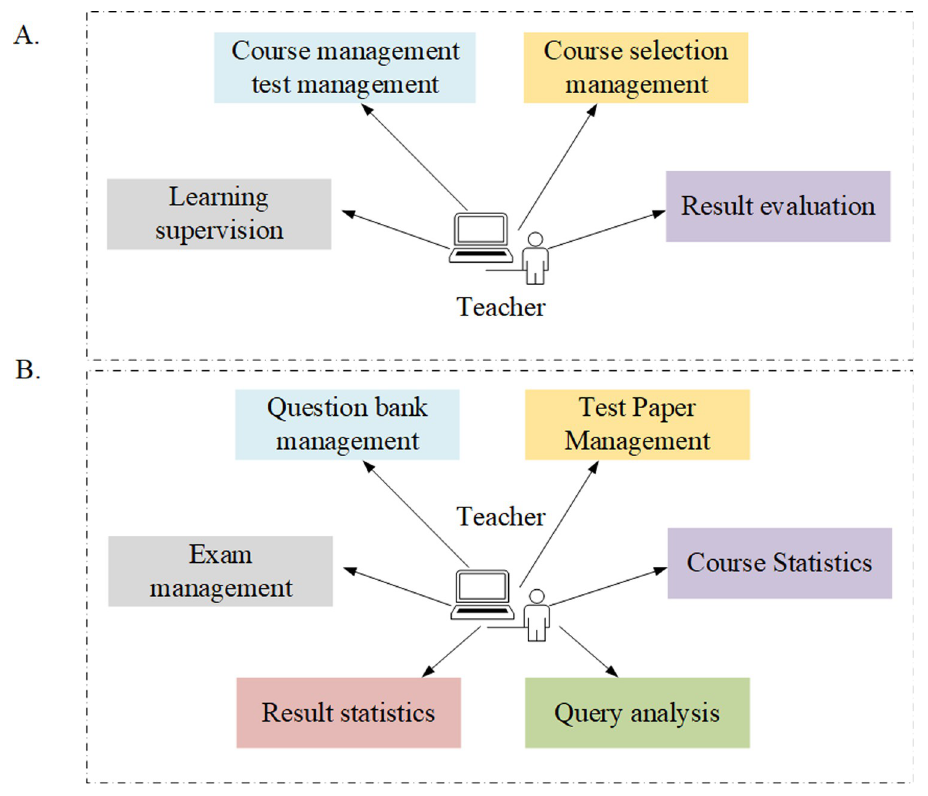
Fig 3. Analysis of teacher learning and examination management